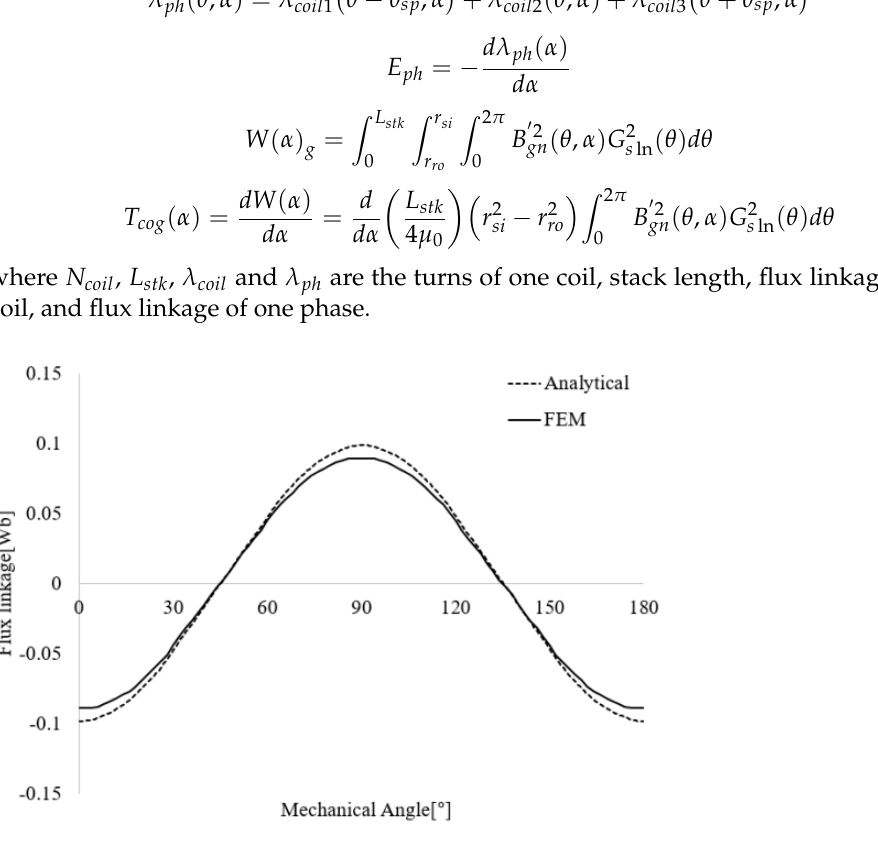
Figure 9. Comparison of the flux linkage derived from the HMEC and FEM.